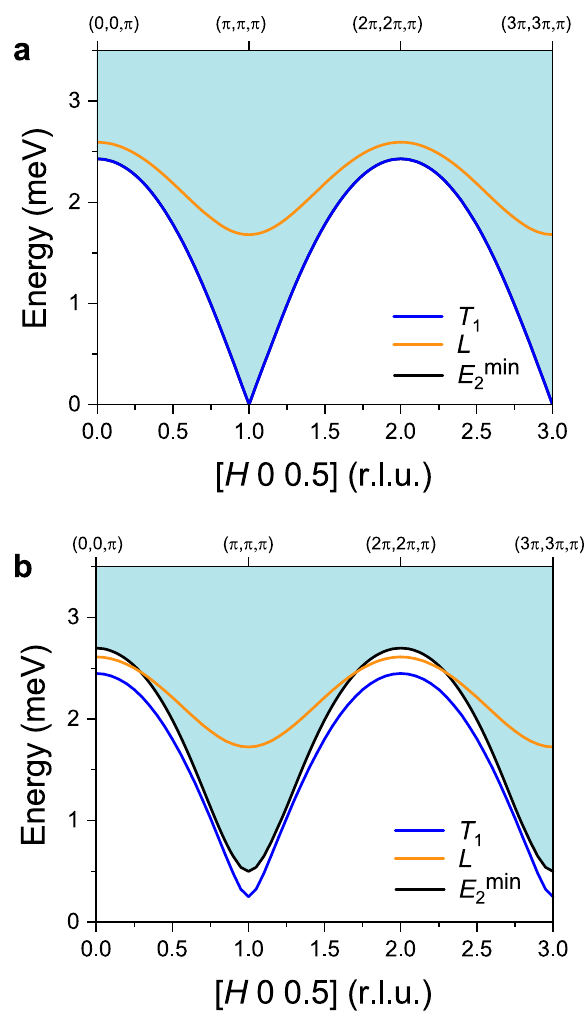
Fig. 8 Kinematic constraints for the decay of the longitudinal mode. The blue (orange) curve shows the calculated transverse (longitudinal) band dispersions along [ H , 0, 0.5] with the GLSWT (using parameters set B in Table 1). The light blue-shaded areas indicate the two-transverse mode continuum, whose lower edge is indicated with a black solid line ( E min a Results of the effective S ¼ 1 model. b Same as a but for a gapped branch of transverse modes (an ad hoc gap has been added to Eq.